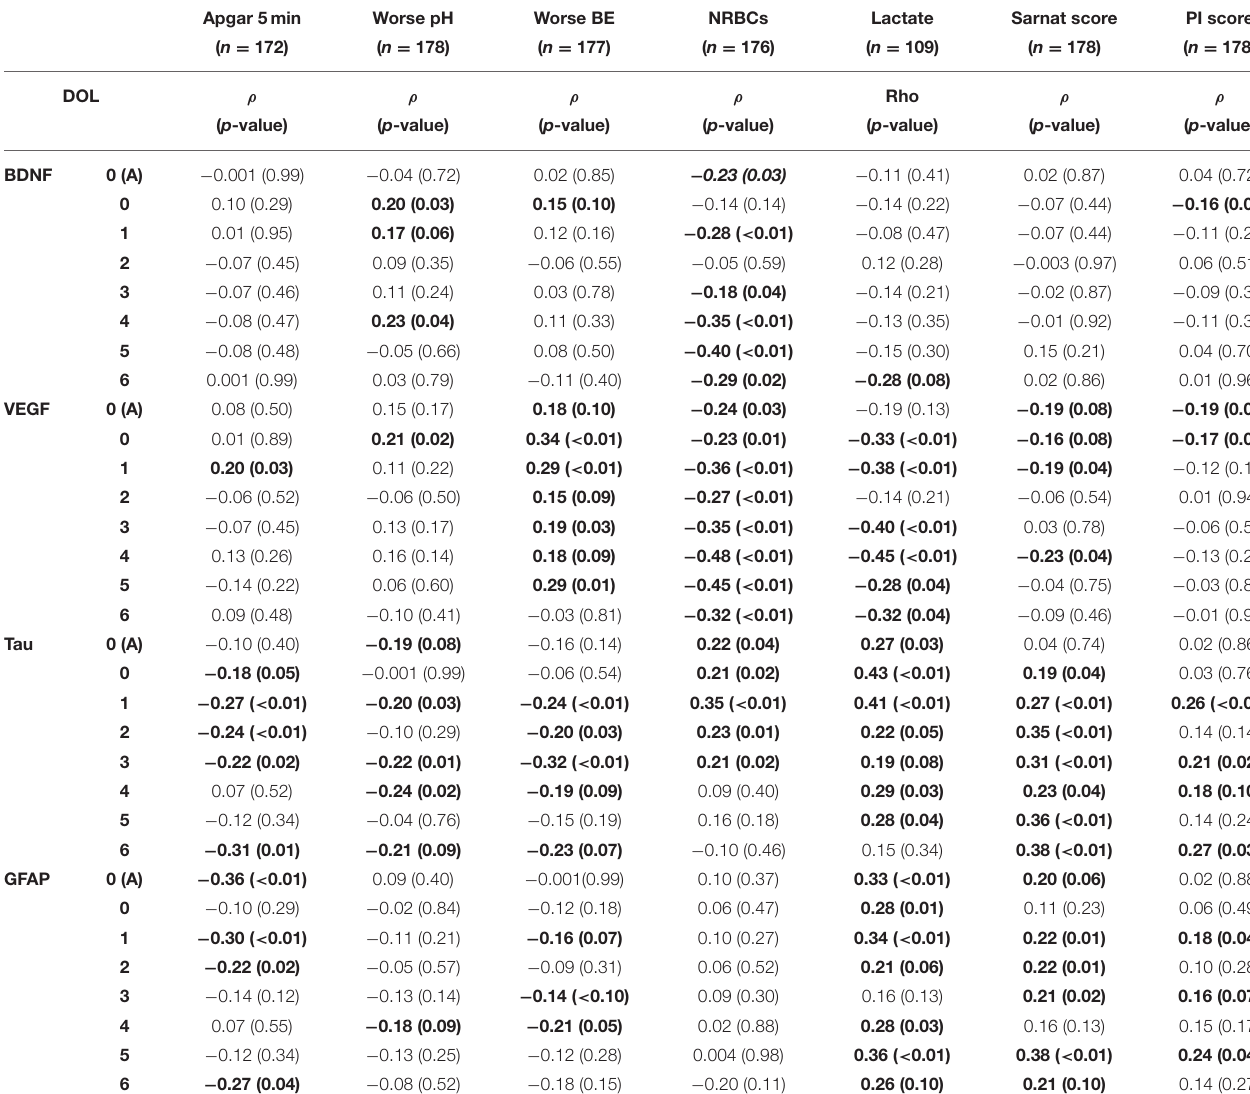
TABLE 4A | Correlation between indicators of HI severity and BDNF, VEGF, tau, and GFAP during the first week of life. Apgar